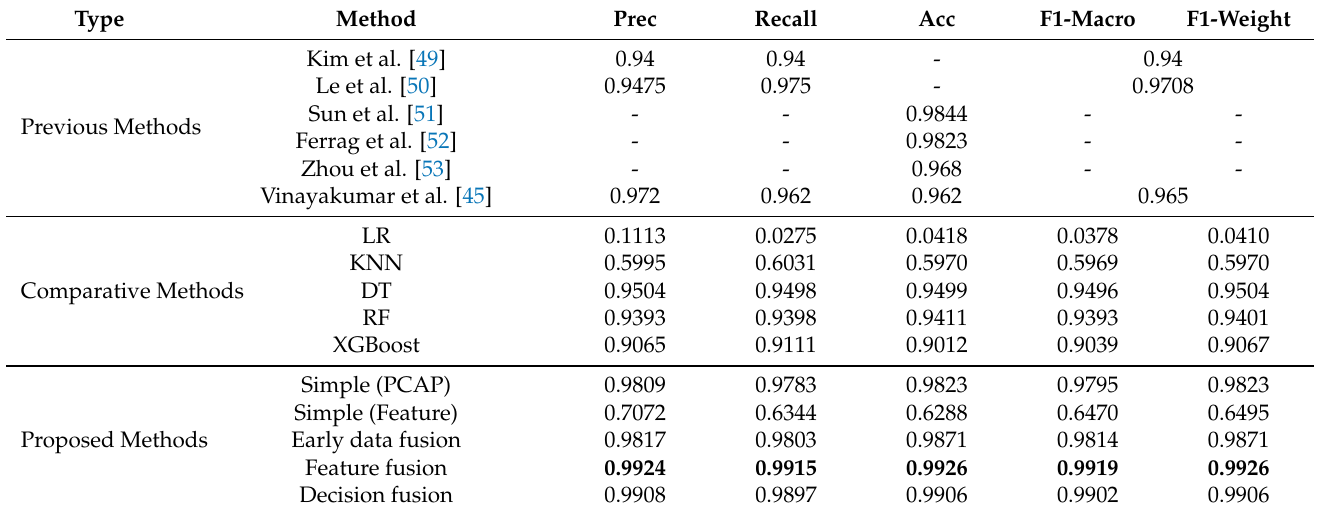
Table 6. Experiment results and comparation of data CIC2012 and CIC2017.